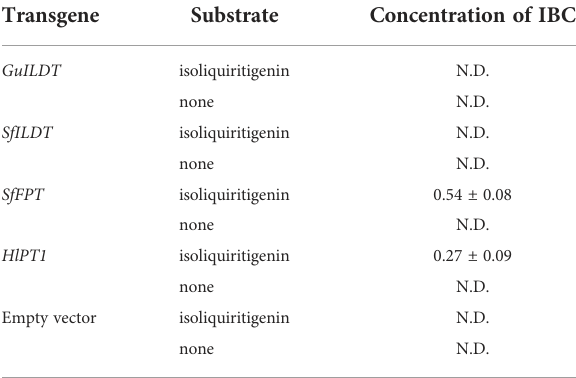
Values shown are the concentration of isobavachalcone (IBC) ( m g/g dry weight). Values are the mean of fi ve biological replicates ± standard error. N.D., not